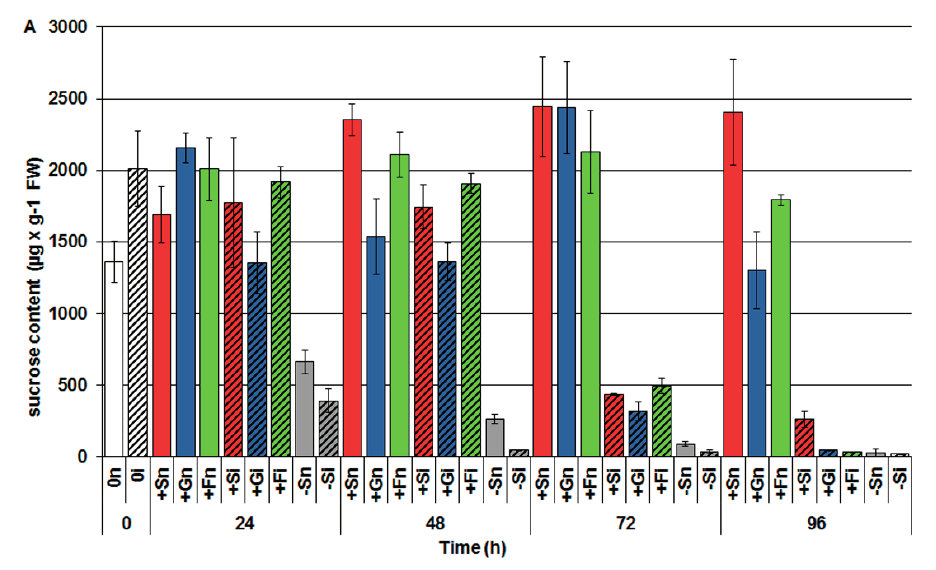
sugars i.e. , sucrose ( A ), glucose ( B ), fructose ( C ) in in vitro cultured embryo axes